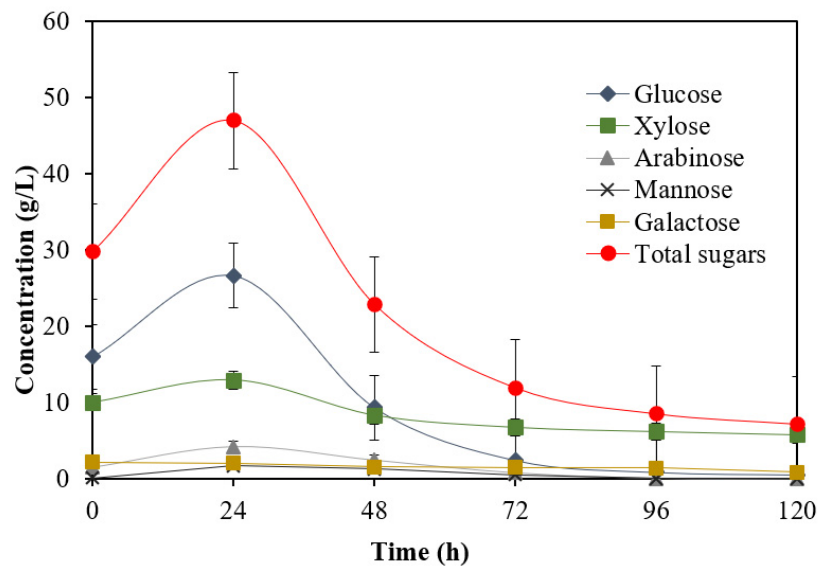
Figure 8. Individual sugar consumption profiles of strain S1 during SSF of WS. Other strains show similar individual sugar consumption patterns during SSF of WS.